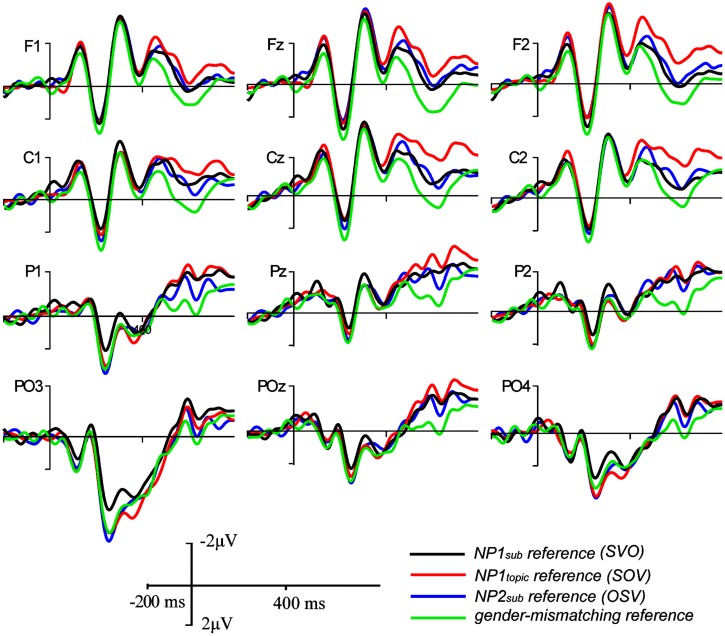
Grand average ERPs time-locked to the critical pronoun in Experiment 1 for the NP1sub reference (SVO structure), the NP1topic reference (SOV structure), the NP2sub reference (OSV structure), and the gender-mismatching reference conditions, respectively.